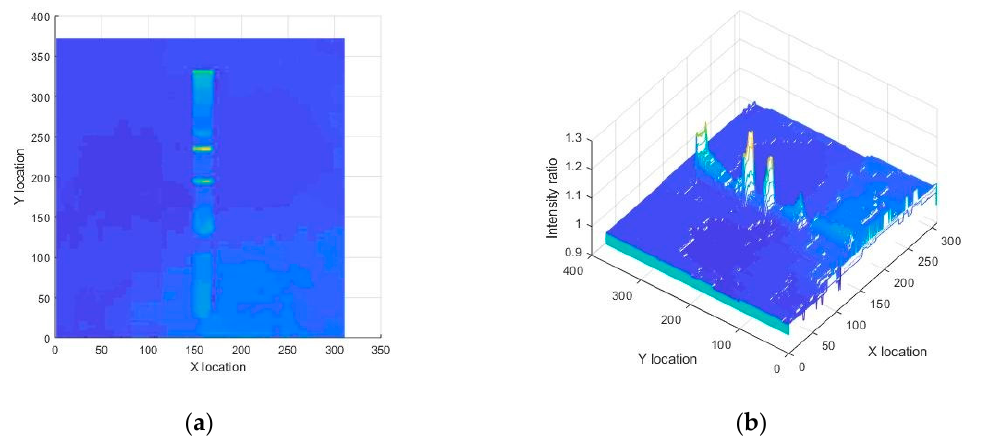
Figure 6. Ratio of red channel to green channel of a sample LFA strip is visualized by ( a ) a 2D surface, and ( b ) a 3D surface. It is clear that the test and control lines had the maximum value that can be used to differentiate them from other regions. to di ff erentiate them from other